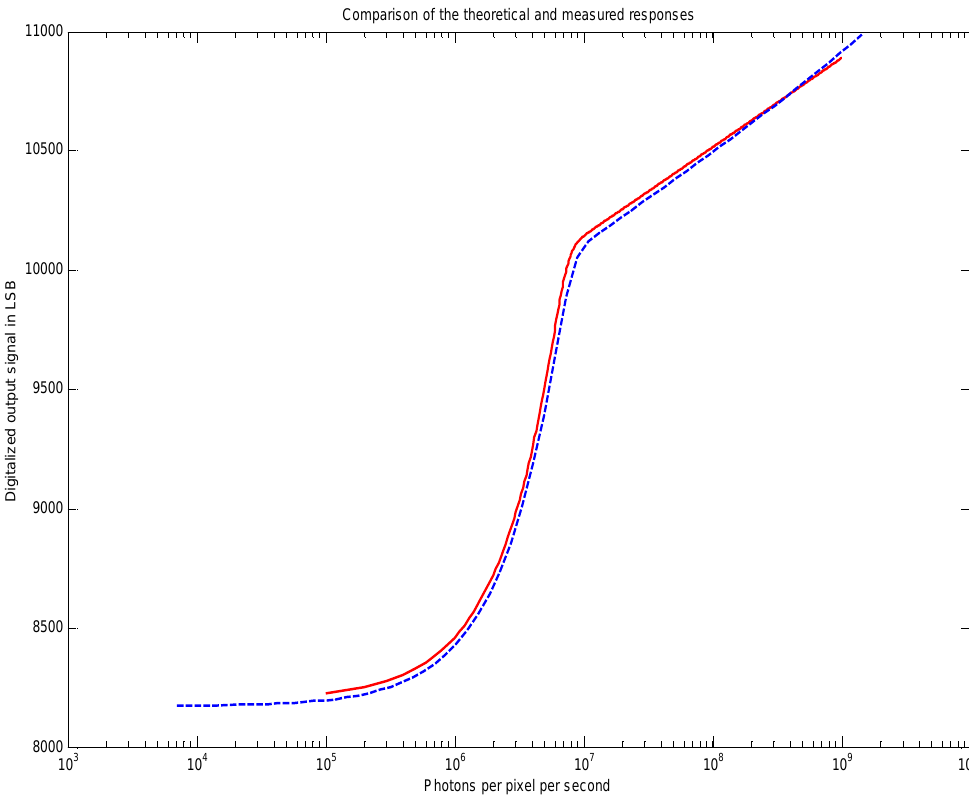
Figure 6. The measured response curve (blue dashed) superposed with the calculated response from Equation (4). The exposure time was set at 20 ms and estimated quantum efficiency was about 5% (Fill-Factor = 8%). The operating temperature of the sensor was 25 °C.